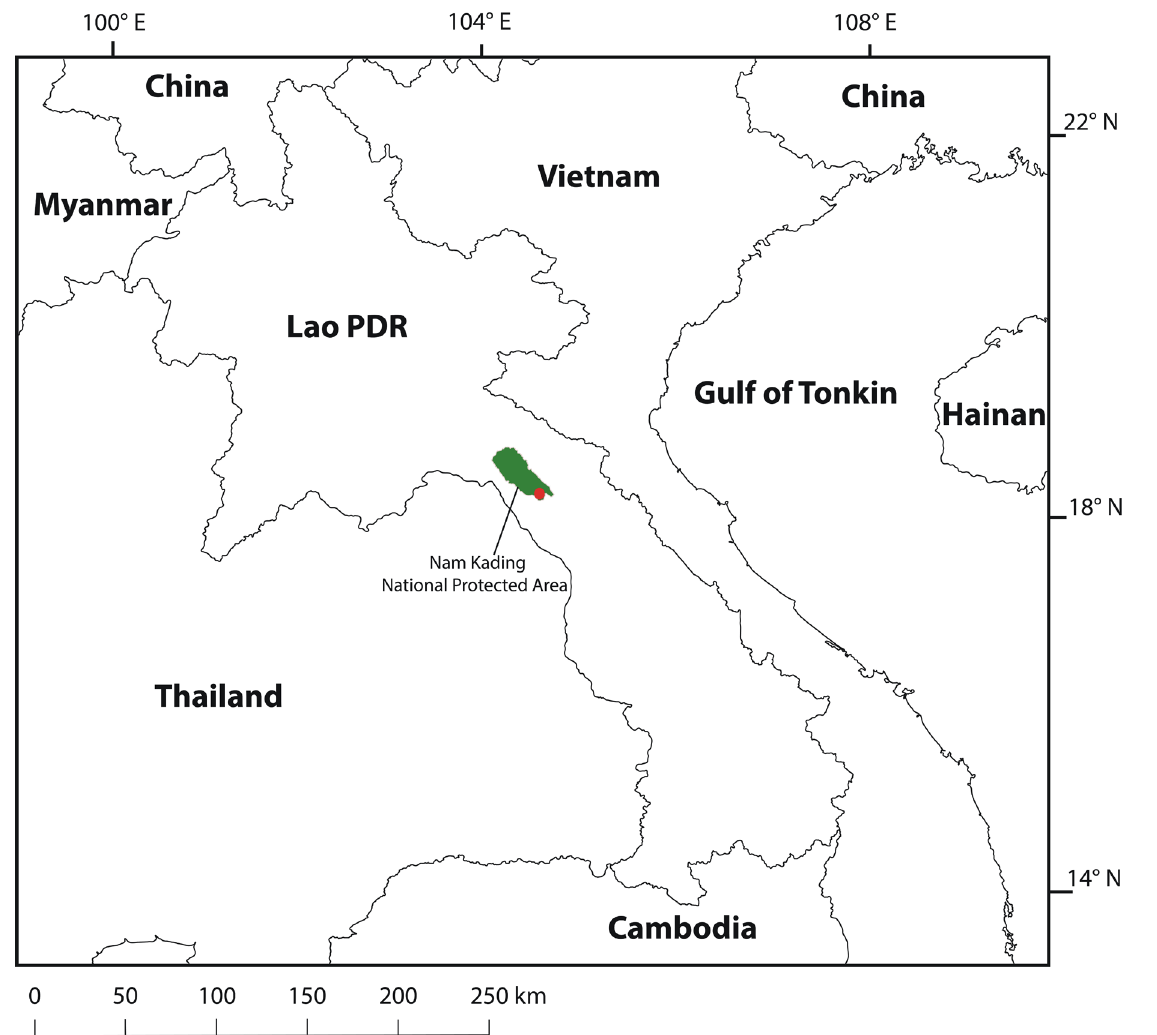
Fig. 3. Known distribution of Capparis macrantha Souvannakhoummane, Fici & Lanorsavanh sp. nov . (red